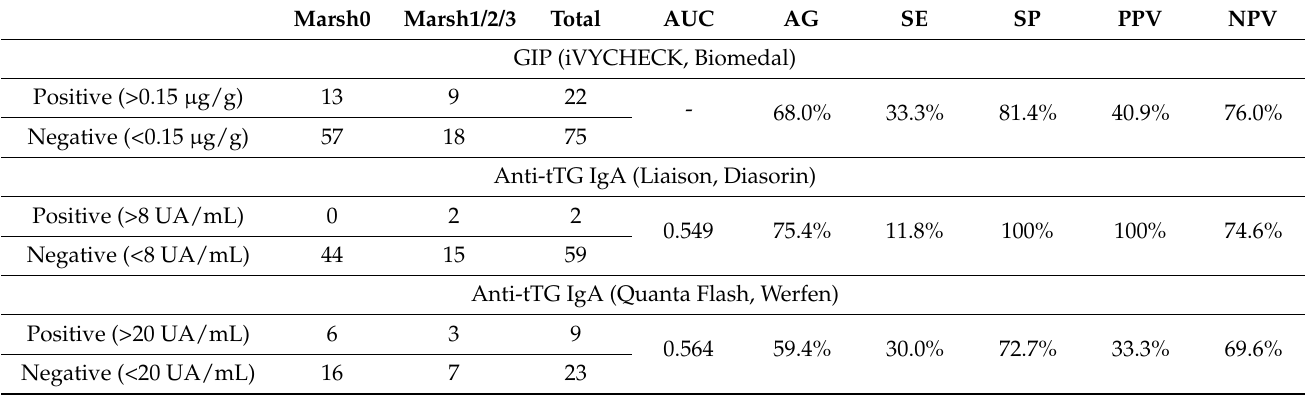
Table 2. Diagnostic performance of presence of gluten immunogenic peptides (GIPs) in stool and serum anti-tissue